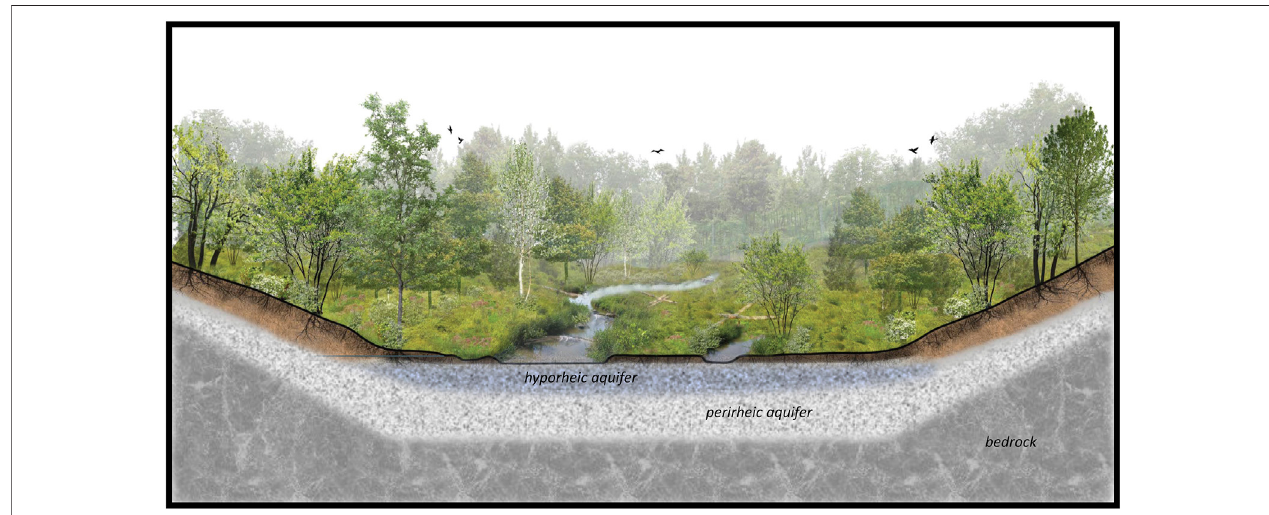
FIGURE6| Schematicrepresentationofafullyconnectedstreamcorridorwherebiogeomorphicprocesses(e.g.largewood,beaver,vegetation)andriver-wetland attributes (e.g. valley geometry, channel planforms, channel migration, hyporheic and regional aquifers) interact in complex ways, via multiple, nested feedback loops. Original illustration provided by LandStudies, Inc., Pennsylvania (with permission from Land Studies, 2021).